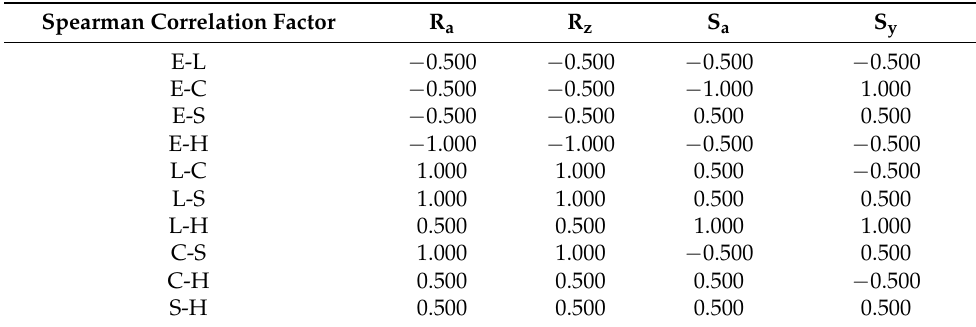
Table 5. Correlation factor values related to material, after conditioning. E (Enamic), L (Lava Ultimate), H (Hyramic), S (Shofu), C (Cerasmart). Spearman Correlation